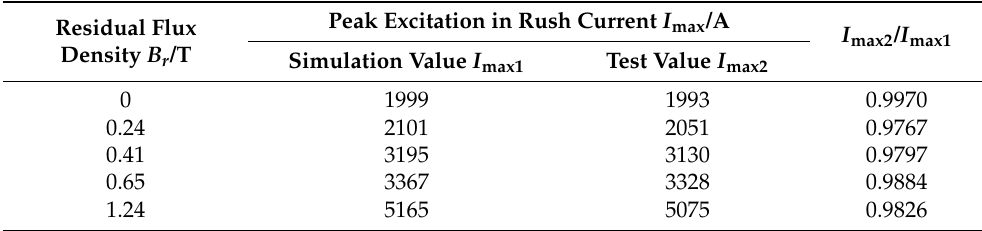
Table 2. The peak inrush current I max under different residual flux B r when the closing angle θ = 0 ◦ .